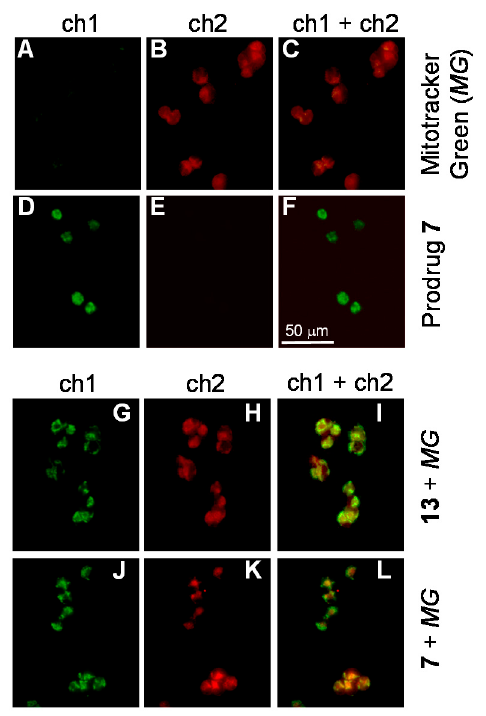
Figure 4. A – C : Incubation of A2780 cells with Mitotracker green (MG, 100 nM) for 30 min and imaging the cells using channels 1 (ch1: excitation in the range of 450–490 nm and emission in the range of 500–550 nm) and 2 (ch2: excitation in the range of 538–563 nm and emission in the range of 570–640 nm). Mathematical sum of ch1 and ch2 is shown in inset C . D – F : The same as A – C , except that MG was replaced with prodrug 7 (100 nM). G – I : The same as A – C , except that MG was replaced with a mixture of control 13 (100 nM) and MG (1 eq). Pearson’s coefficient is 0.93; J – L : The same as A – C ,